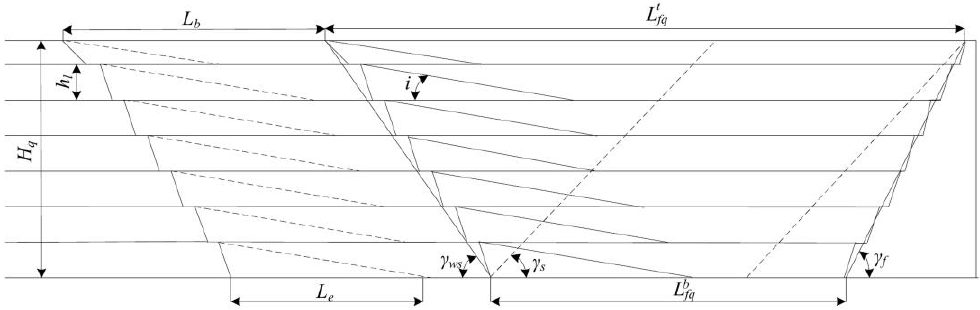
Figure 2. Scheme for calculating the parameters of the first-stage pit with a block-and-layer continuous lateral mining method.